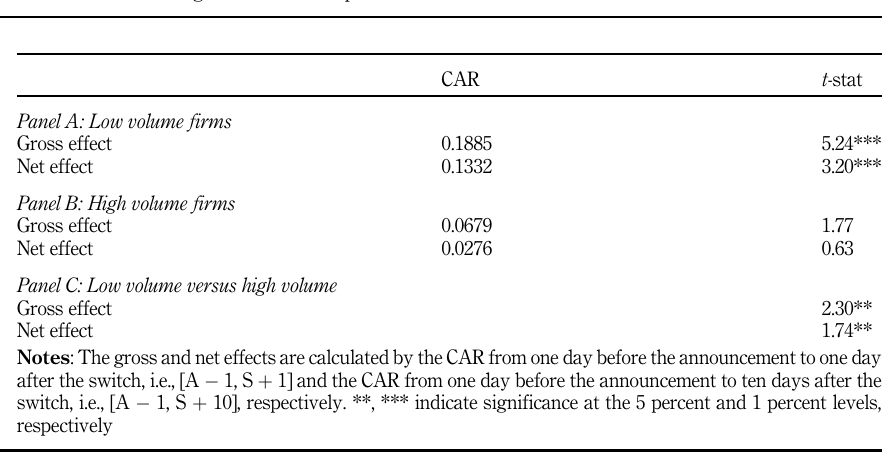
Table VI. Robustness test - Price reaction around the switch